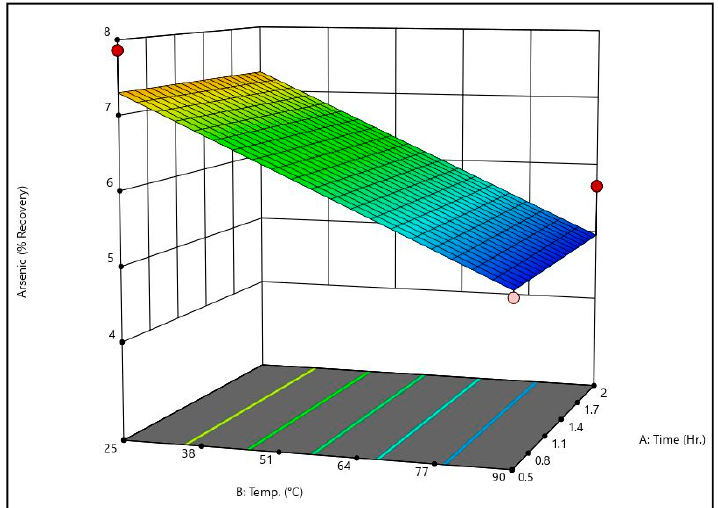
Figure 15. Water leach arsenic recovery response surface.